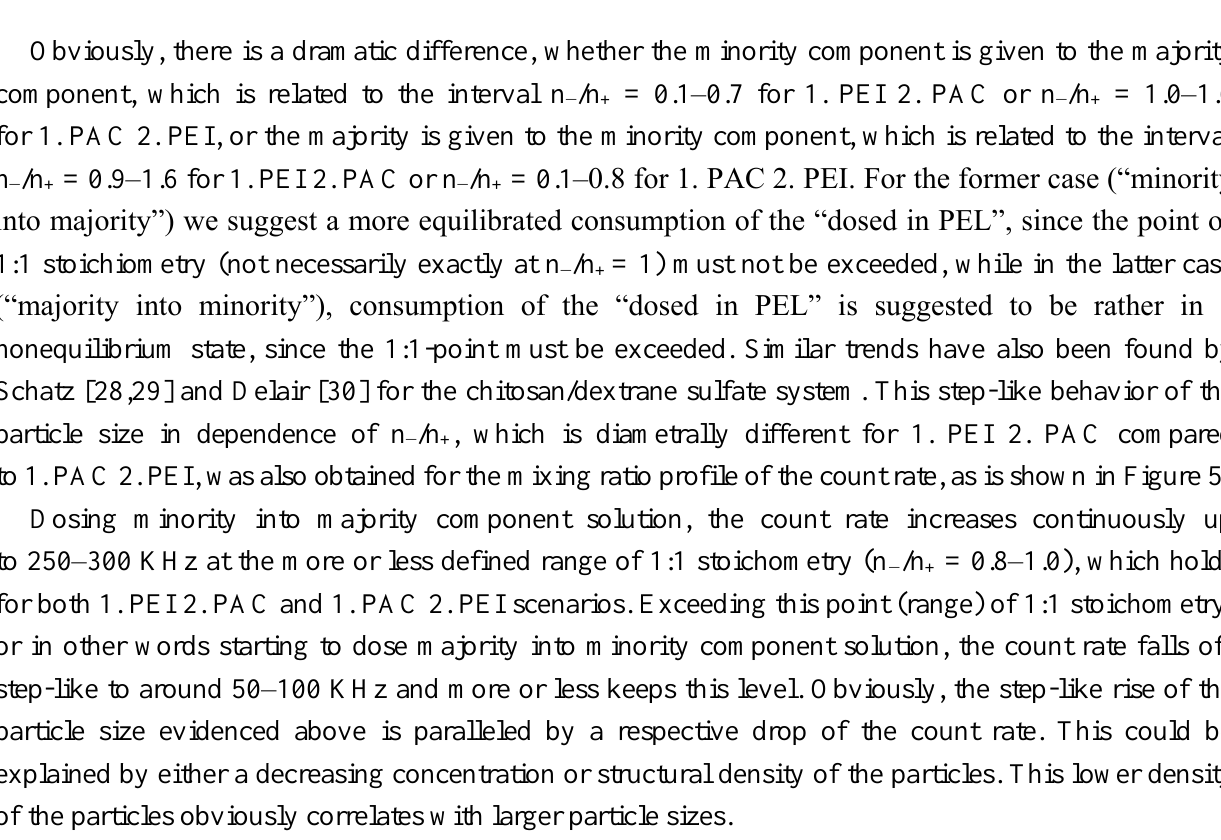
Figure 4. Size of PEI/PAC particles versus n